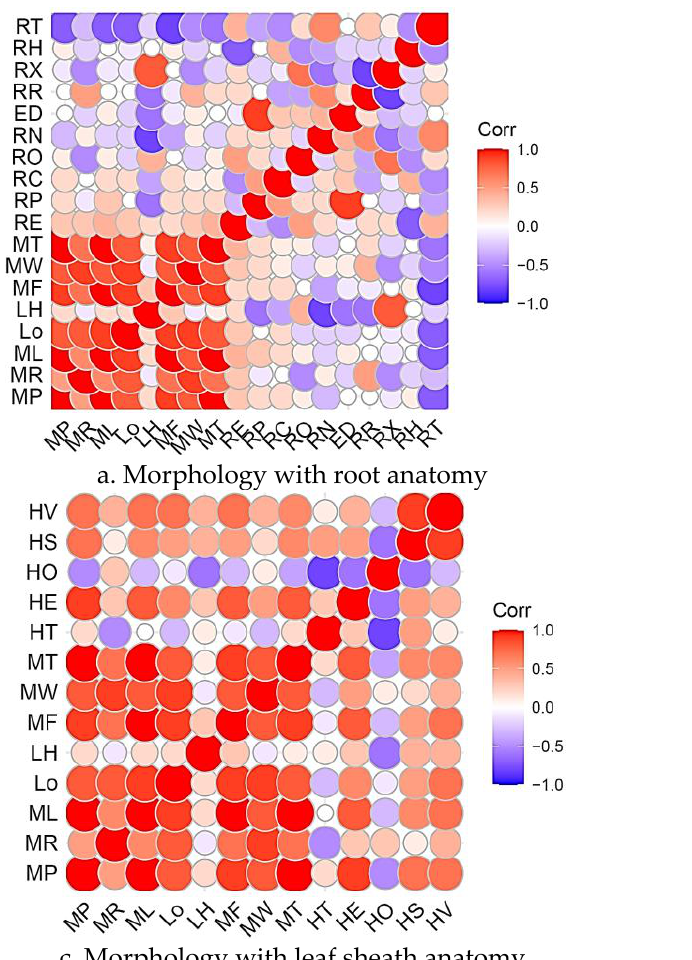
Figure 5. Pearson ’ s correlation coefficients computed for morphology with root ( a ), stem ( b ), leaf sheath ( c ) and leaf blade ( d ) anatomy of Dactyloctenium aegyptium treated with pre- and post-emergence herbicides. For abbreviations please see list at the end of manuscript.